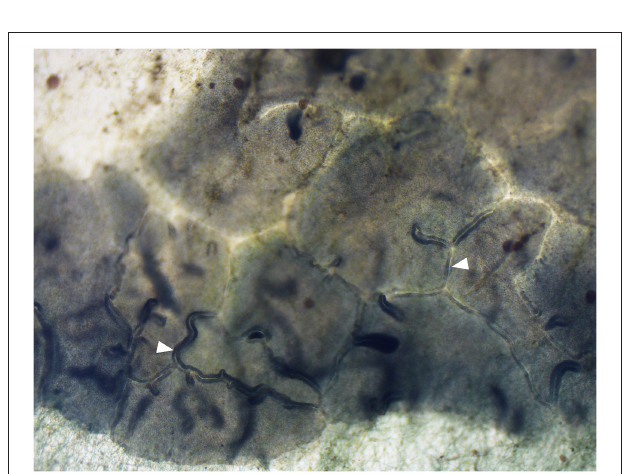
FIGURE 2 | Magnification o f T. adhaerens aggregate on the aquarium wall biofilm. White arrowheads indicate the contact points between Placozoa. Magnification: